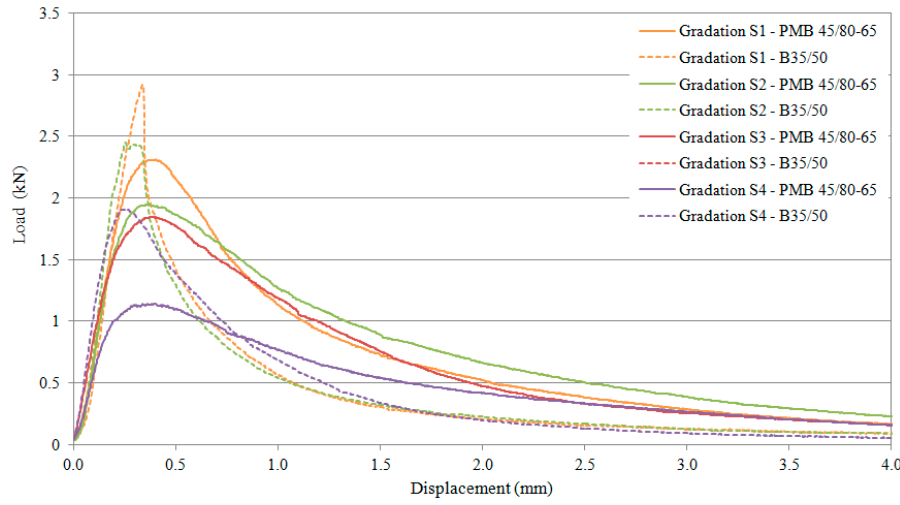
Figure 9. Stress-displacement curve at a test temperature of 20 °C.